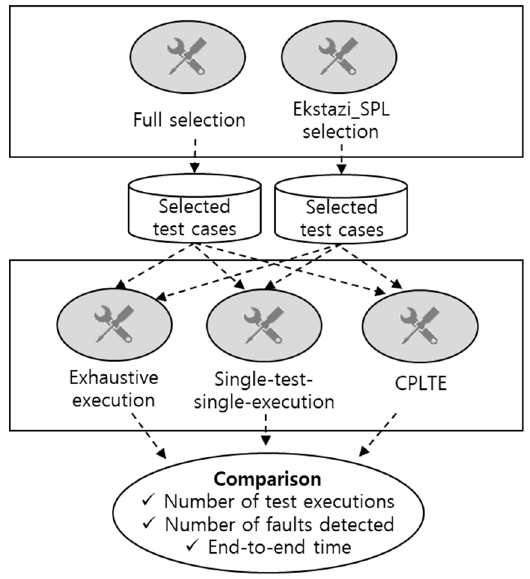
Figure 4. Process of our experiment.